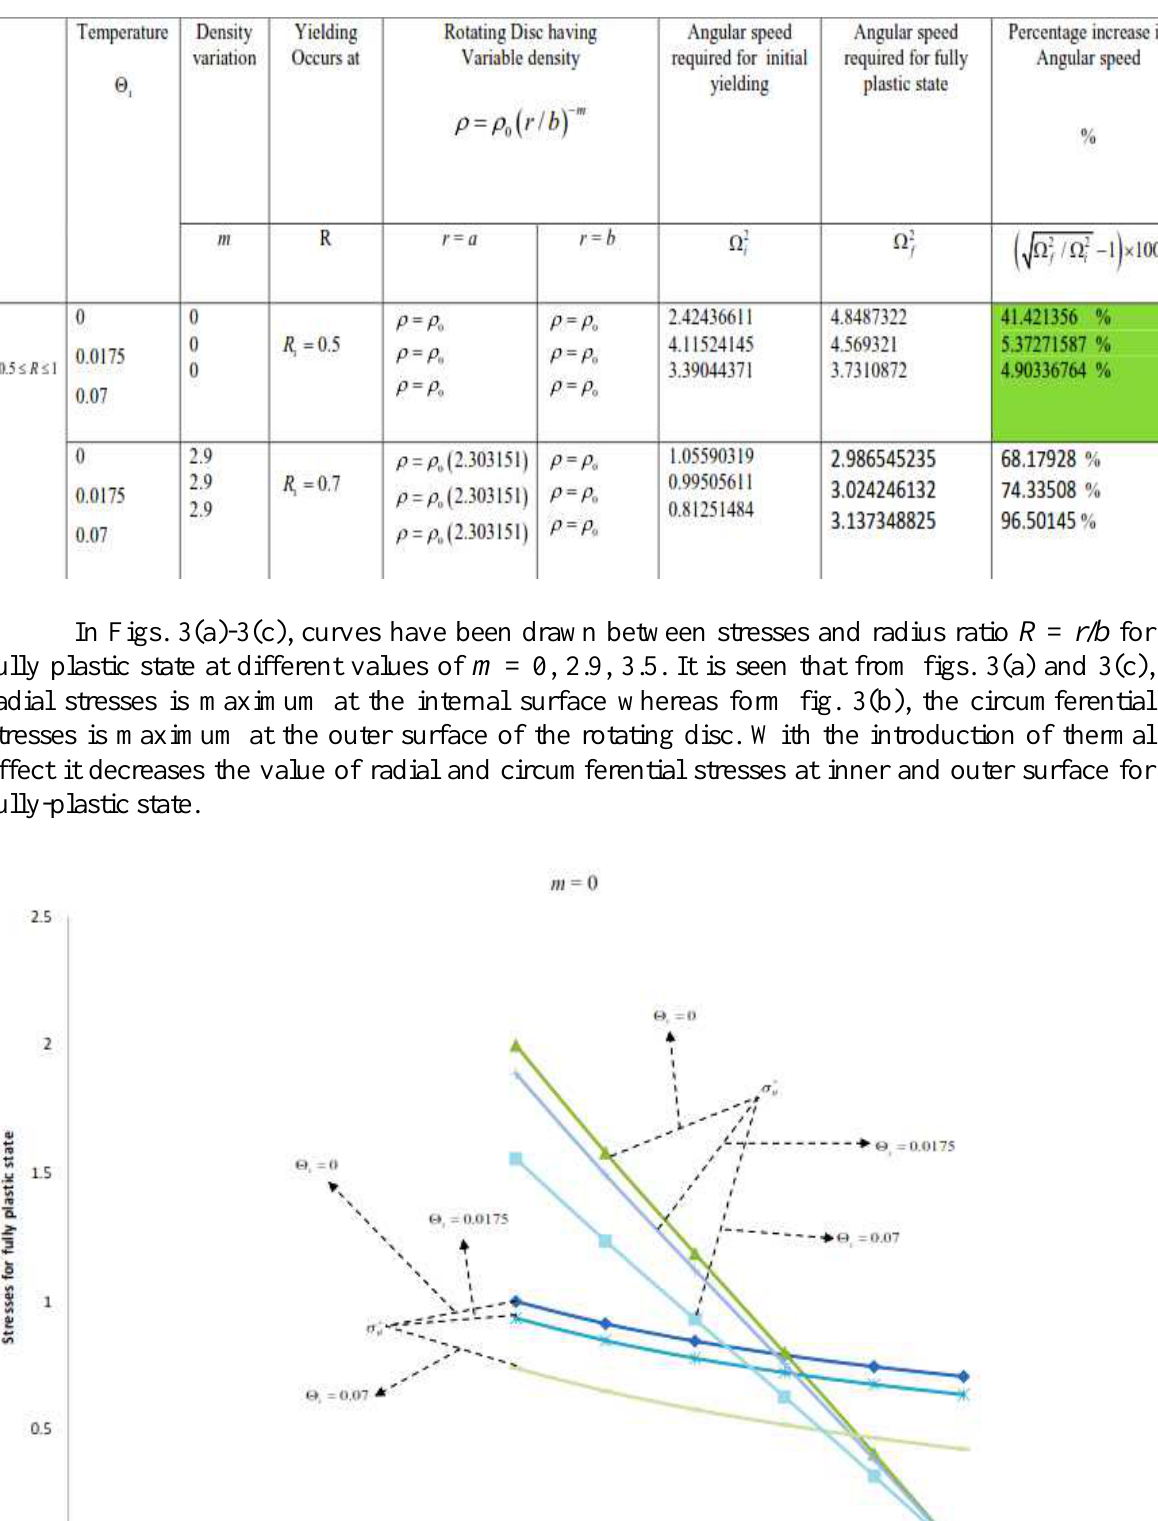
W and fully plastic state 2 i